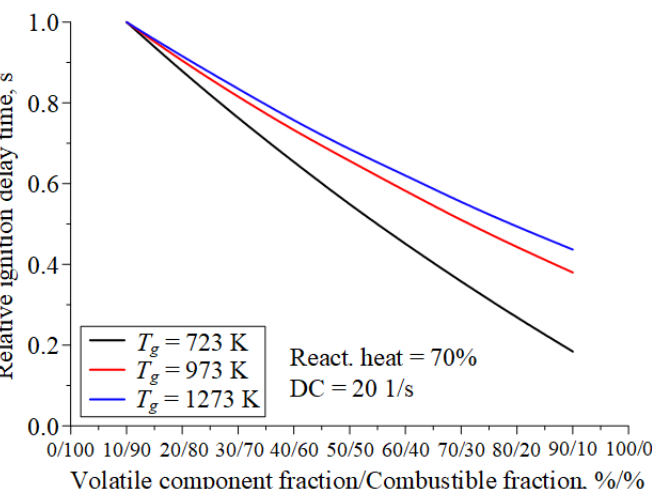
Figure 8. Relative ignition-delay times of CLF vs. volatile component fraction/combustible fraction ratio of the combusting particle at different temperatures of the radiant heating source.